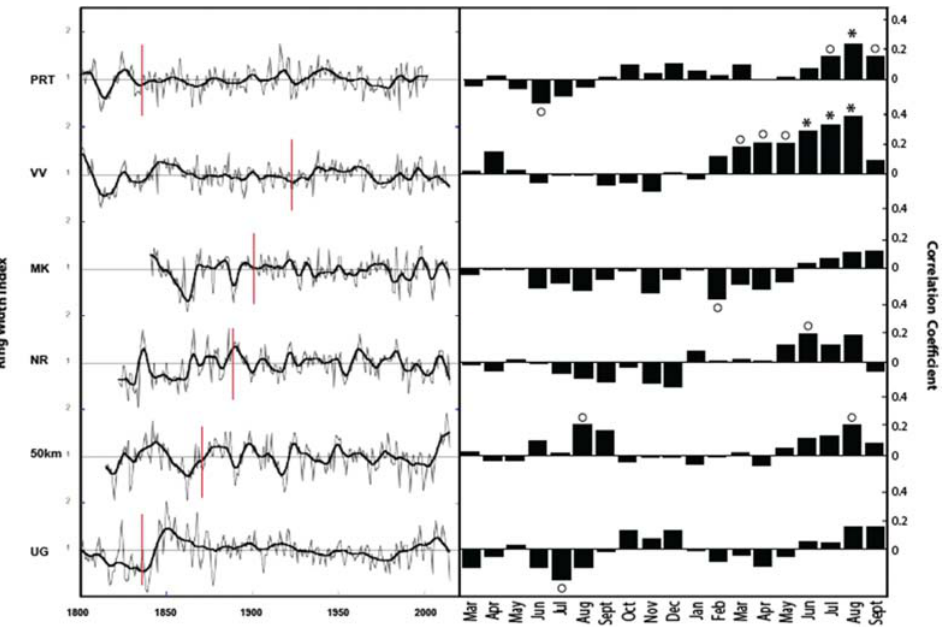
Figure 3. Left, Birch chronologies starting from 1800, ordered in increasing altitude from bottom to top Label elevations. Red vertical lines indicate when EPS exceeds 0.85. Thick line shows values smoothed with a 6% weighted curve. Right, correlations with Petropavlovsk and Klyuchi mean temperature of 19 months, from prior March–December through September of the current growth year are shown on the right. ° denotes a correlation significant at a 90% confidence level, whereas * denotes a correlation significant at the 99% confidence level.